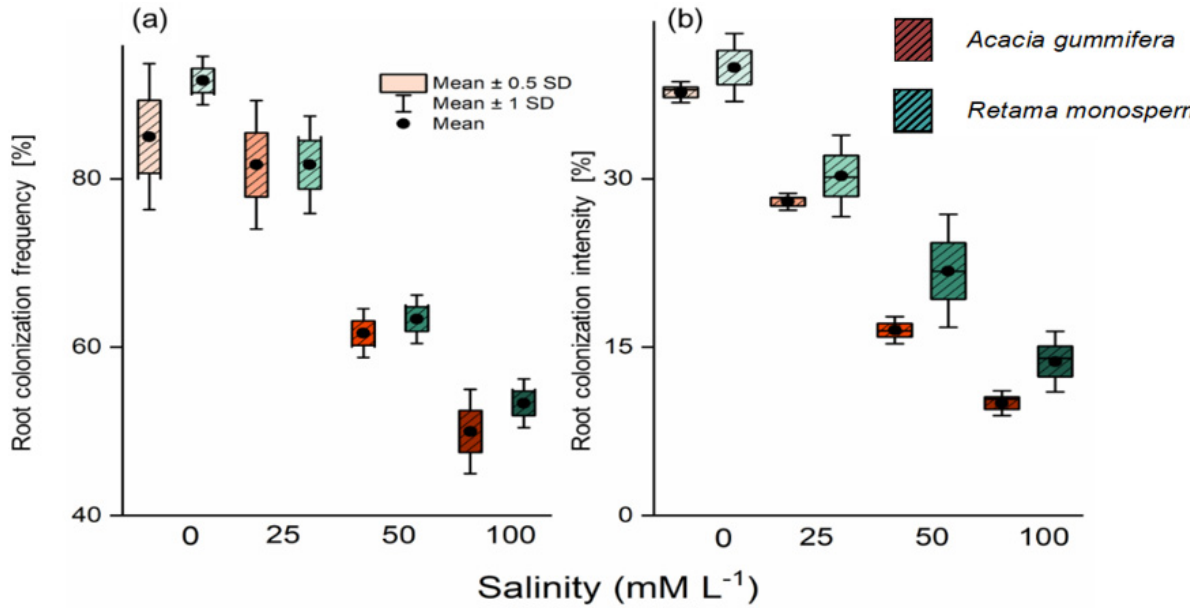
Figure 1. Boxplots of mycorrhizal frequency ( a ) and intensity ( b ) of the inoculated Acacia gummifera and Retama monosperma plants under different salinity levels (0, 25, 50 and 100 mM NaCl). At the different salinity concentration, A. gummifera species are represented by antiwhite and brown colors, and R. monosperma species are shown by tea-green, and green colors, respectively.